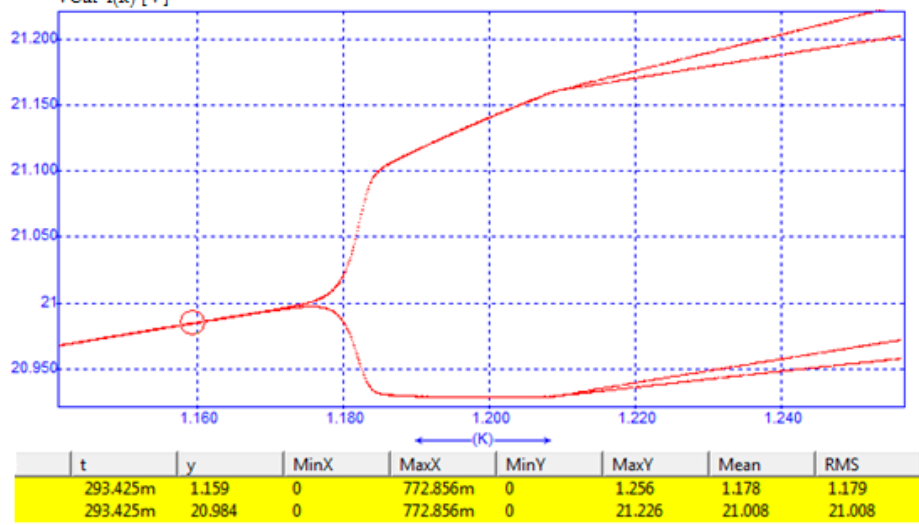
Figure 5. The simulated bifurcation diagram of the boost DCM converter employing proportional voltage-mode control.